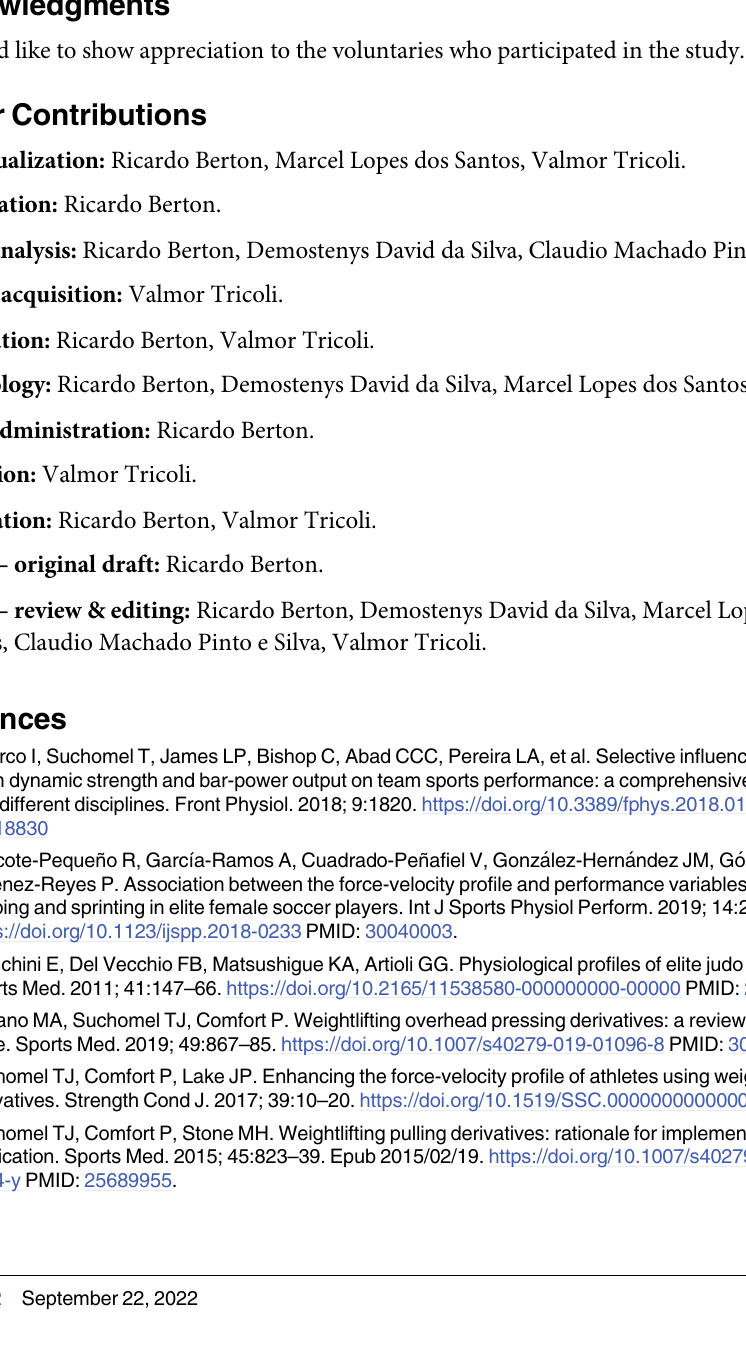
S1 Fig. (A) Adjustable wooden structures positioned on each side of the force plate (black arrows = measuring tapes, white arrow = elastic band); (B) example of the adjustment for the squat jump. After using a goniometer to determine the 90˚ knee flexion angle, the range of motion was demarcated by contact of the gluteus with the elastic band; (C) aerial phase of the squat jump. S2 Fig. The load progression in the WL group was represented by the adjustments per- formed in the power clean from the knee